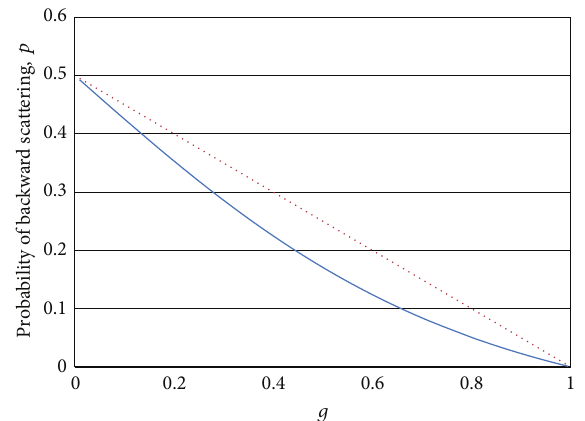
Figure 1: Probability of backward scattering 𝑝(𝑔) in the Heiney- Greenstein model (solid line) and 1D model (dotted line) as a function of 𝑔